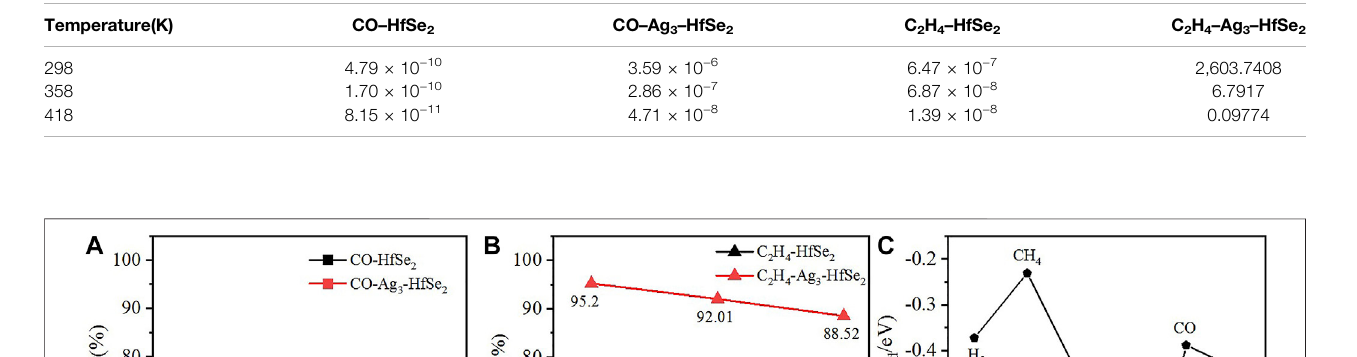
Frontiers in Chemistry |